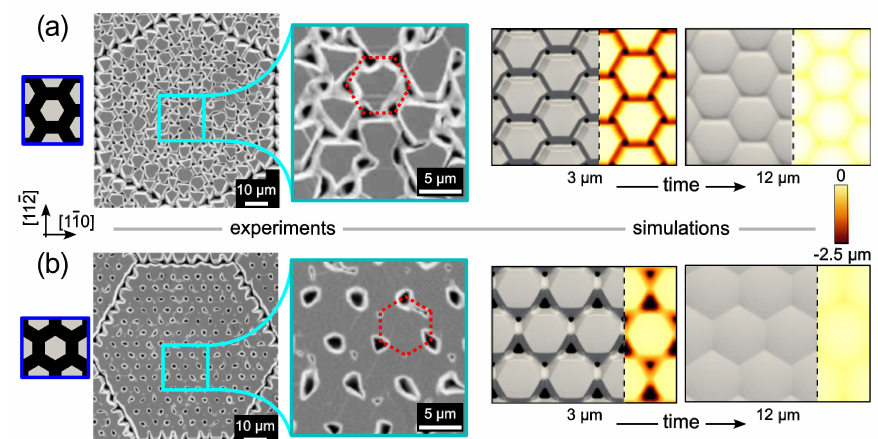
Figure 5. Comparative analysis of the coalescence of SiC crystals grown on Si pillars for the two different patterns with pillar rows along ( a ) the [11-2] and ( b ) [1-10] directions from both experiments and simulations. SEM views are reported for samples obtained after 12 µ m SiC deposition on 5 µ m large prismatic Si pillars, spaced by 2 µ m gaps. The magnified views highlight the different patterns of holes left by partial coalescence. Simulation snapshots are shown for both the 3 and 12 µ m deposition. The colored regions show the variations in height by the colormap. A smoother profile is achieved in case ( b ) (see Reference